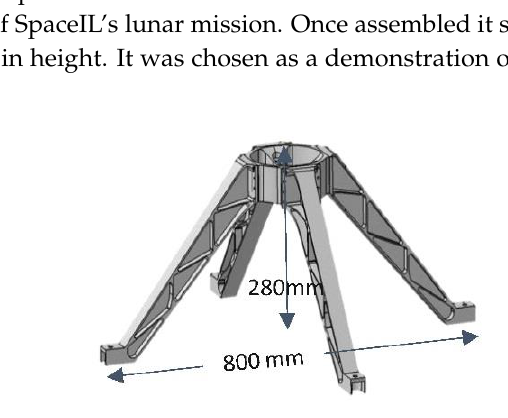
Figure 4. Nominal insert design geometry.